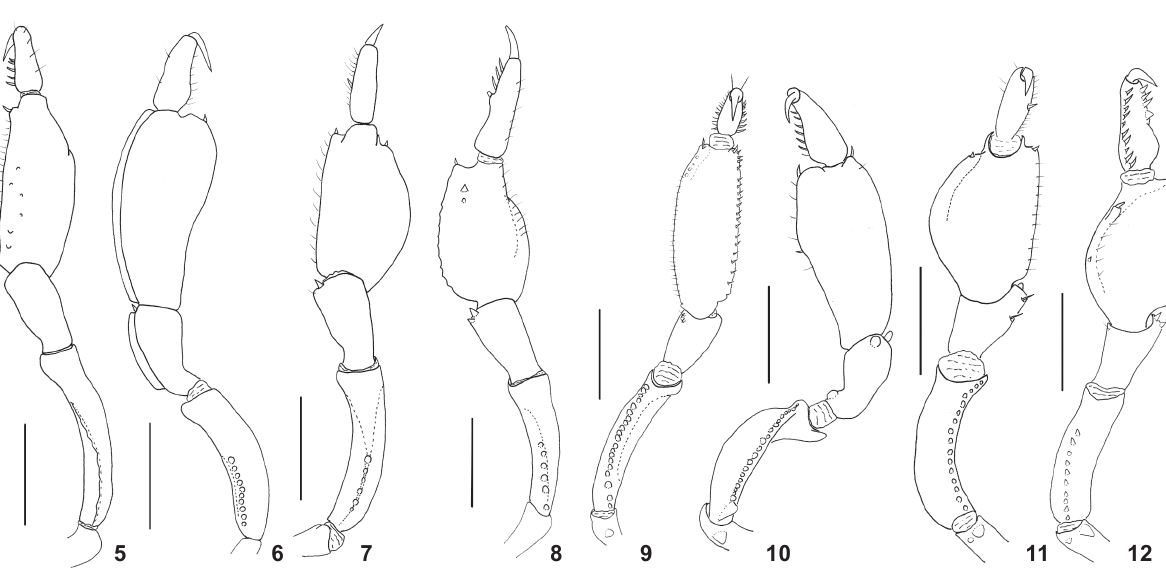
Figures 5-12. Right pedipalpus of males of Cosmetus . (5-8) dorsal view: (5) Cosmetus pollera sp. nov. ; (6) Cosmetus balboa sp. nov. ; (7) Cosmetus burbayar sp. nov. ; (8) Cosmetus tamboritos sp. nov. (9-12) ventral view: (9) Cosmetus pollera sp. nov. ; (10) Cosmetus balboa sp. nov. ; (11) Cosmetus burbayar sp. nov. ; (12) Cosmetus tamboritos sp. nov. Scale bars = 1